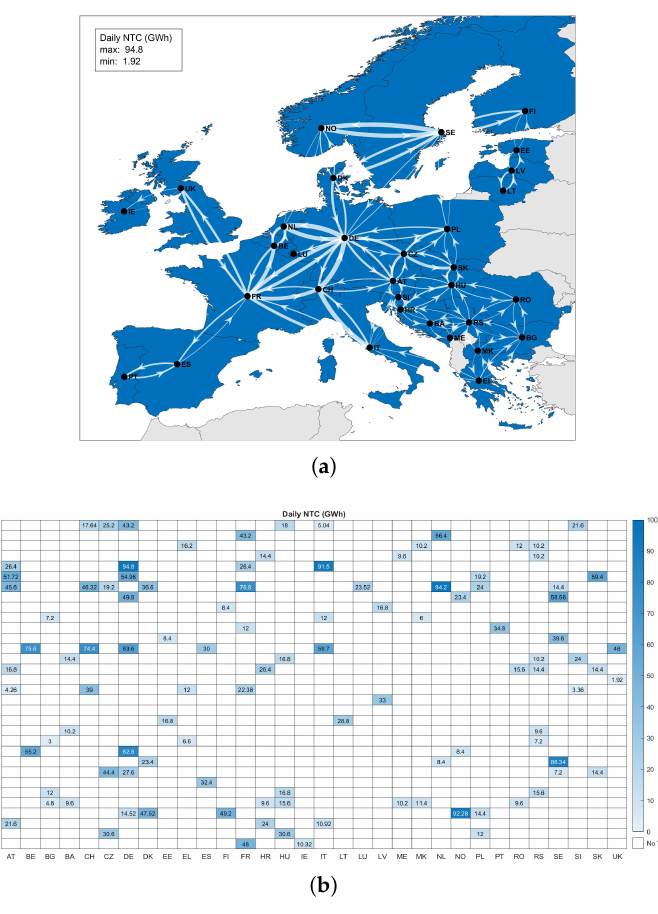
Figure 5. Graph ( a ) and tabular ( b ) representation of the cross-border daily net transmission capacity